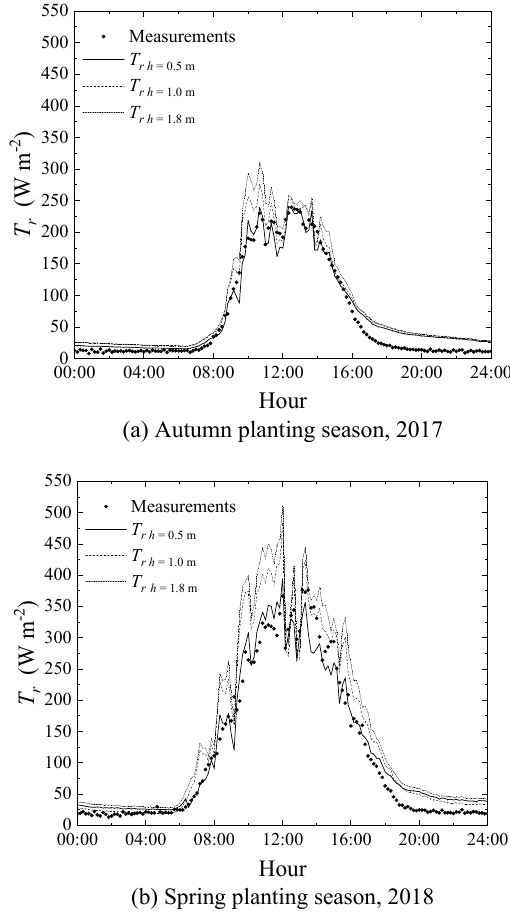
Figure 7. Variations of the measured and estimated average T r values by the Stanghellini model (SM) based on the meteorological data at three observation heights ( a ) from 2 to 10 November 2017 and ( b ) from 2 to 10 May 2018.